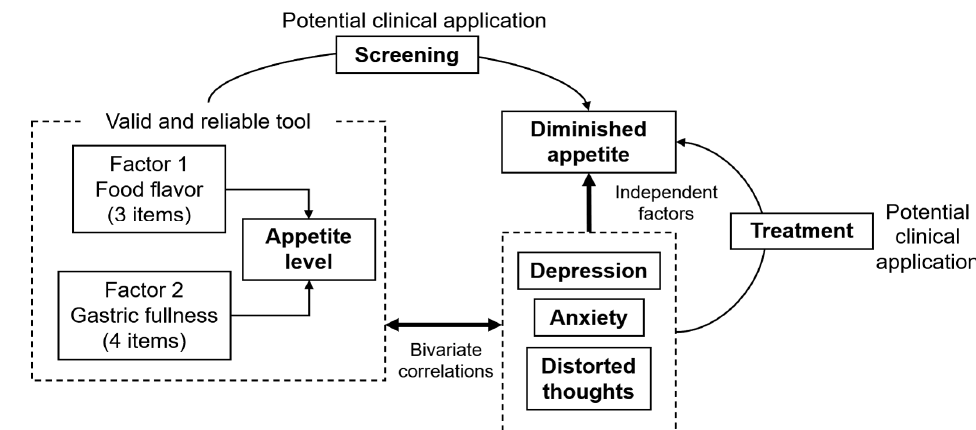
Figure 3. Diagram of the main contributions of the current study. The adapted questionnaire is a simple, valid, and reliable tool to assess appetite level in Spanish-speaking patients treated with hemodialysis. The ROC curve analysis showed that a low score discriminates against those patients with diminished appetite, with a potential application as a screening tool. Depression symptoms, anxiety symptoms, and distorted thoughts are independent factors of diminished appetite. Treatment of these psychological variables may be useful to improve appetite level.